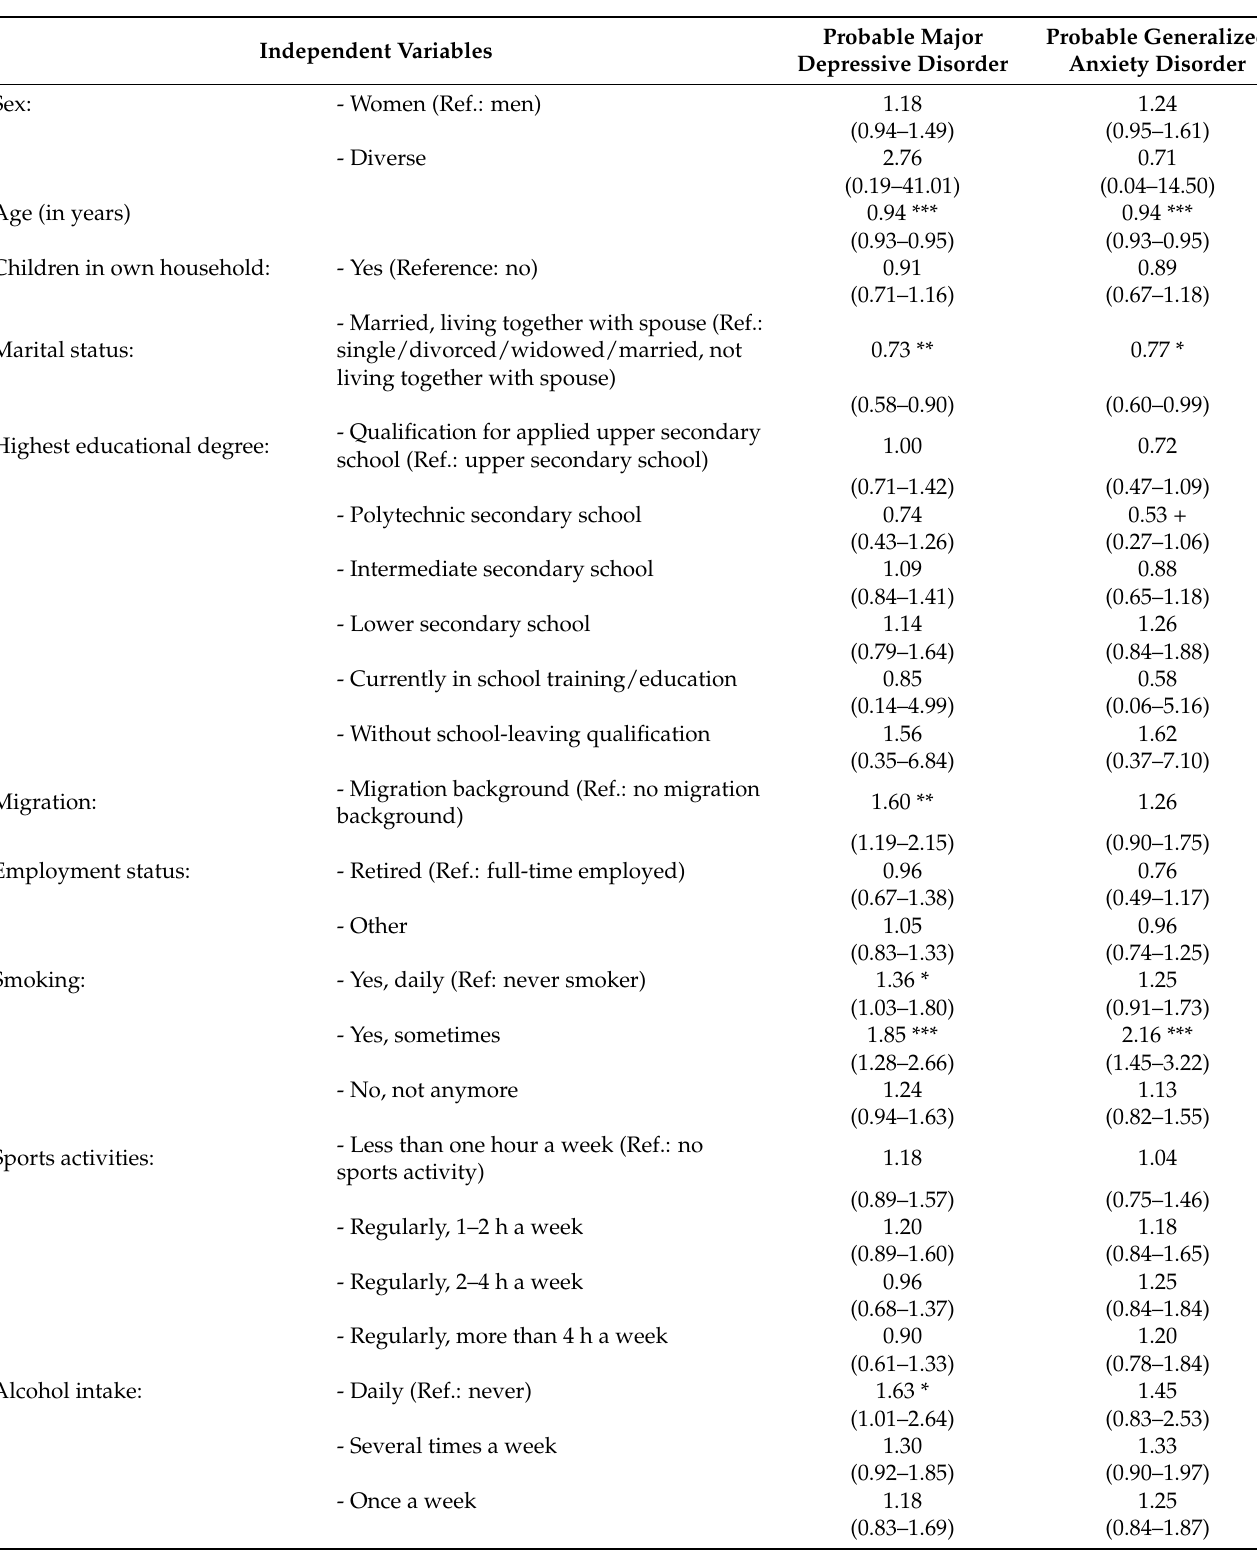
Table 2. Correlates of probable major depressive disorder and probable generalized anxiety disorder. Results of multiple logistic regressions. Independent Variables